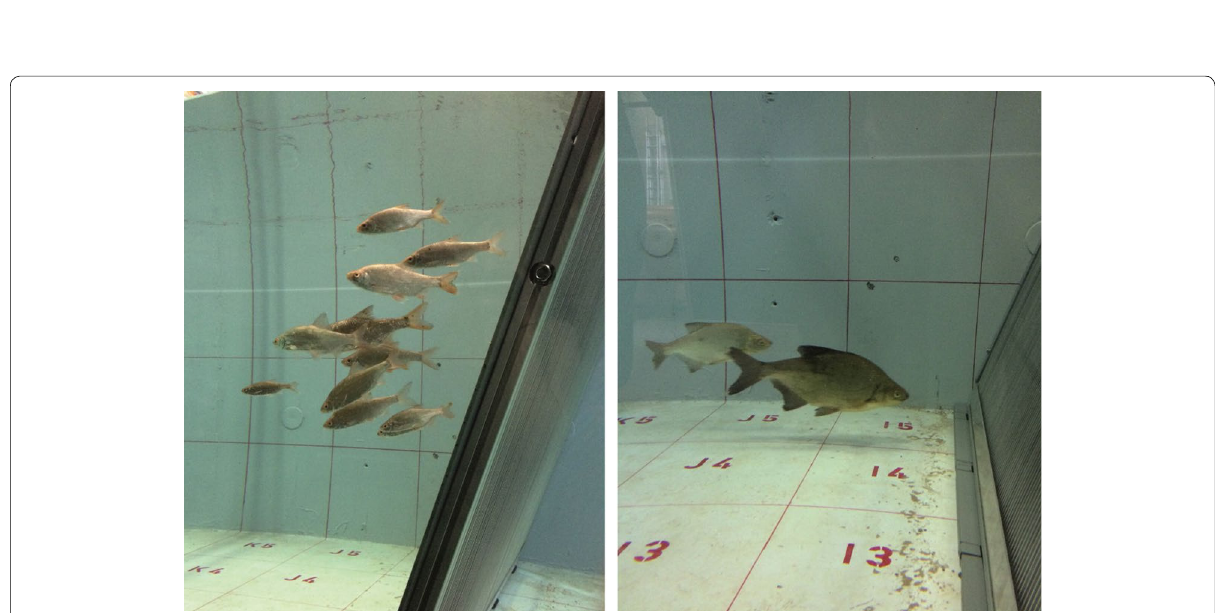
Fig. 4 Behavioural studies on fish within the flow channel. Different types of bar racks are tested on common roaches ( Rutilus rutilus , left) and com‑ mon breams ( Abramis brama ,